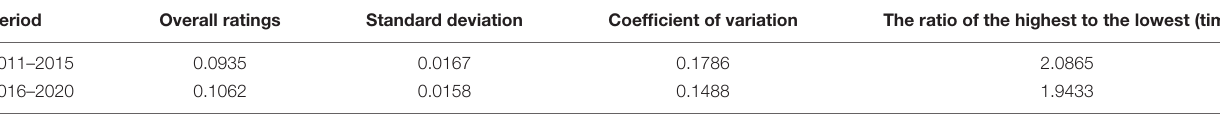
The ratio of eastern to The ratio of the central part (take west as 1) middle (take middle as 1) to the western part (take west as 1)